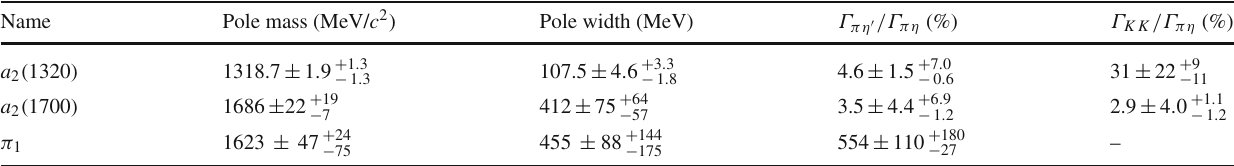
Fig. 2 Fits to the πη (upper row) and πη (cid:2) (lower row) data from COMPASS. The intensities of the P- (left), D-wave (center), and their relative phases (right) are shown. The data are represented by the red points with error bars. The black curve illustrates our best fit to the data, while the yellow and gray bands represent the statistical and systematic uncertainty, respectively Table 1 Obtained masses, total widths and ratios of partial widths for the pole of the spin-exotic π 1 -wave and for the two poles in the a 2 -wave, the a 2 ( 1320 ) and the a 2 ( 1700 ) . The first uncertainty is the statistical and the second the systematic